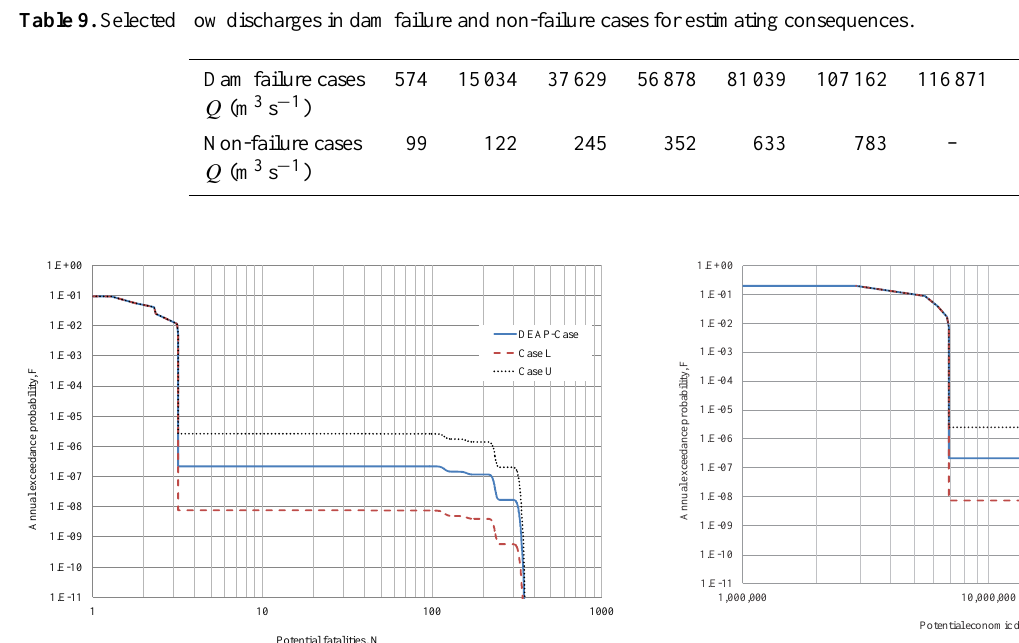
are denoted as Case L and Case U, respectively (best esti- mates were used in the DEAP-Case ). Table 10 shows the es- tablished values from expert judgement for all nodes of the risk model associated with failure modes (Nodes N and D, where a , b , c denote different estimates for the same node based on discharges or overtopping heights).